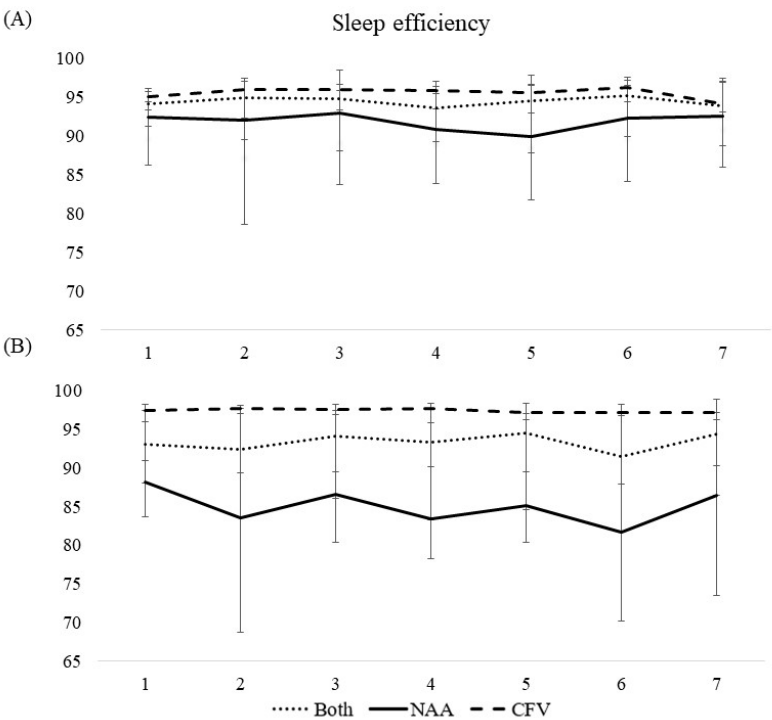
Figure 5. Median scores of sleep efficiency during a 7-day workweek among pilots in the Norwegian Air Ambulance (NAA; n = 25), Christophorus Flugrettungverein (CFV; n = 22), and both groups collapsed, measured by ( A ) sleep diary and ( B ) actigraphy. Error bars represent quartiles.